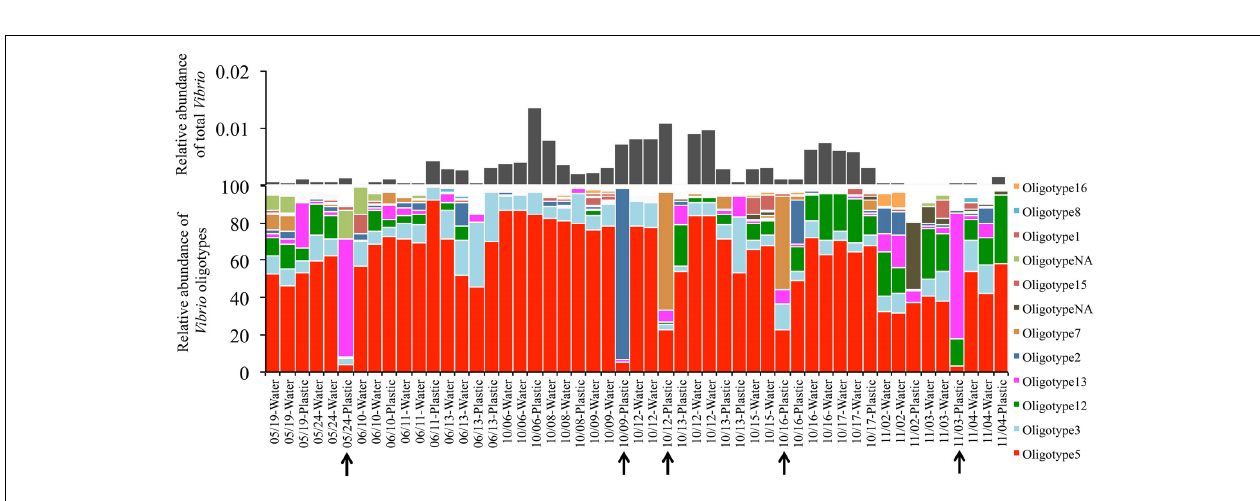
FIGURE 4 | Oligotype distributions for Plastic samples and their surrounding water. Sample labels indicate the date the samples were collected and the sample type. Water and plastic samples collected on the same date are associated with one another. All water was collected at the